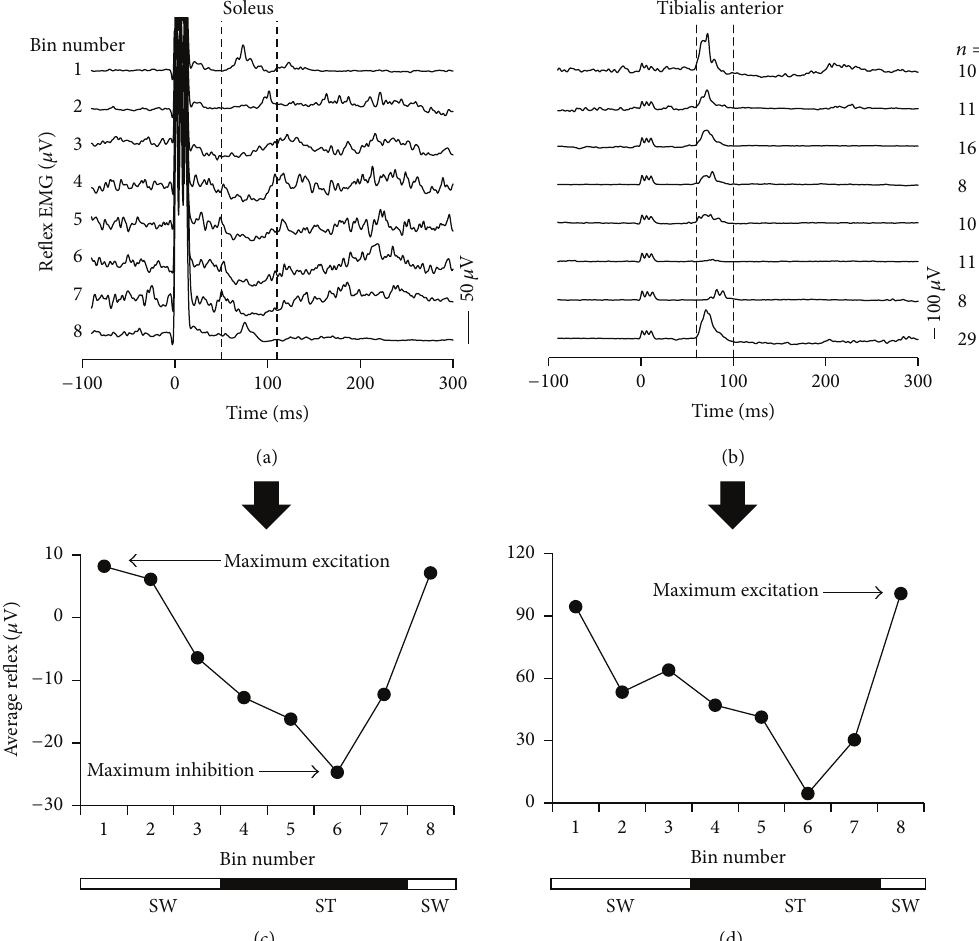
Figure 2: The cutaneomuscular reflex (CMR) during walking in a single participant. Average EMG traces from the soleus (a) and tibialis anterior (b) muscles, time-locked to the beginning of the stimulus (time = 0), are shown for the 8 bins of the walking cycle from participant P12 after subtraction of the background EMG during unperturbed walking. The number of acceptable reflexes within each time bin (bin number) across the step cycle is indicated on the far right. Data were obtained after the first rest period (i.e., at Month 4) prior to Endurance Training.Triplepulses(200 Hz;0.3 mspulsewidth;at ∼ 1.5xmotorthresholdfortheabductorhallucisbrevis(AHB)muscle)wereappliedtothe posterior tibial nerve behind the medial malleolus during walking on a treadmill. Responses displayed are matched for M-wave amplitudes, measured from the AHB (see Data Analyses for details). Responses for each of the 8 bins of the walking cycle were quantified by averaging the EMG between vertical dashed lines in (a) and (b) and plotted as a function of time in the walking cycle in (c) and (d). Correspondences of the bin numbers with stance (ST) and swing (SW) phases are shown by the solid and open bars, respectively, at the bottom of the graphs. Horizontal arrows in (c) and (d) indicate maximum inhibition and